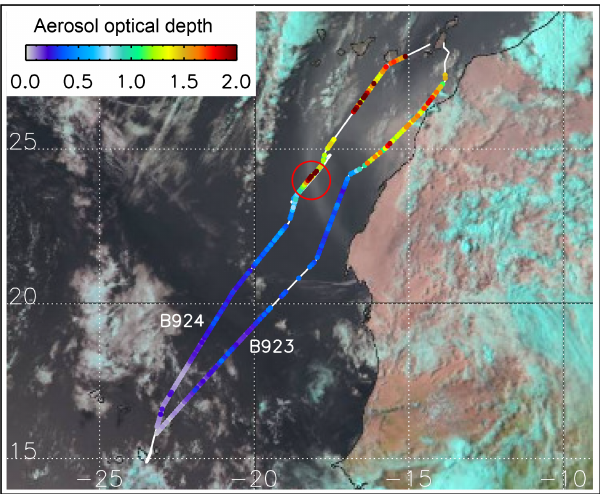
Figure 3. Meteosat Second Generation “321 RGB” image for 12 August at 16:30UTC, showing the extent of the dust plume ad- vected off the west coast of Africa. The track of flights B923 and B924 is overplotted. A colour scale depicts the lidar-derived AOD, and a red circle indicates the location where the aircraft descended to sample the heavy dust in situ. A SLR at 30m altitude was per- formed between 15:52 and 16:04UTC (run 4), and a SLR at 1000m took place between 16:09 and 16:29UTC (run